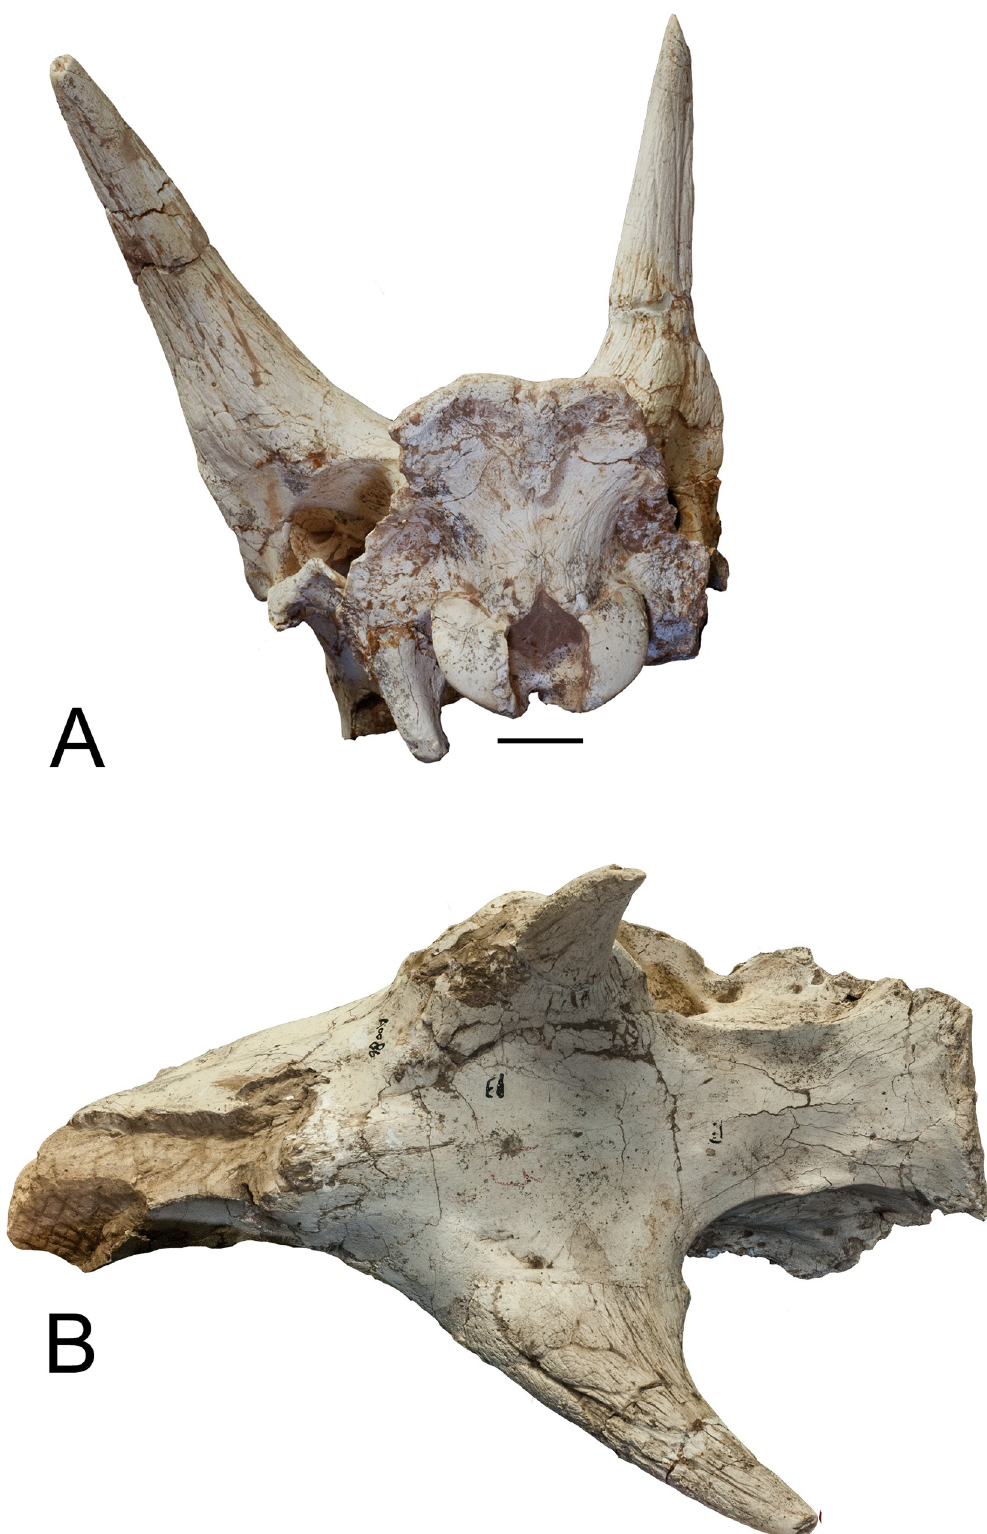
Fig 15. Samotherium boissieri. (A) Occipital aspect of skull HMV IVPP V20271. (B) Dorsal view of skull. Scale 50mm.